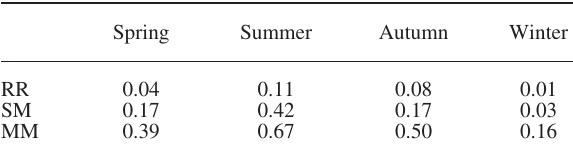
Table 5. – estimation of nitrogen fixation rate (mmol n m -2 day -1 )* of intertidal communities in sanya Bay. RR= Reefs and rocky sedi- ments; sM= seagrass and macroalgal communities; MM= Micro- bial mats.